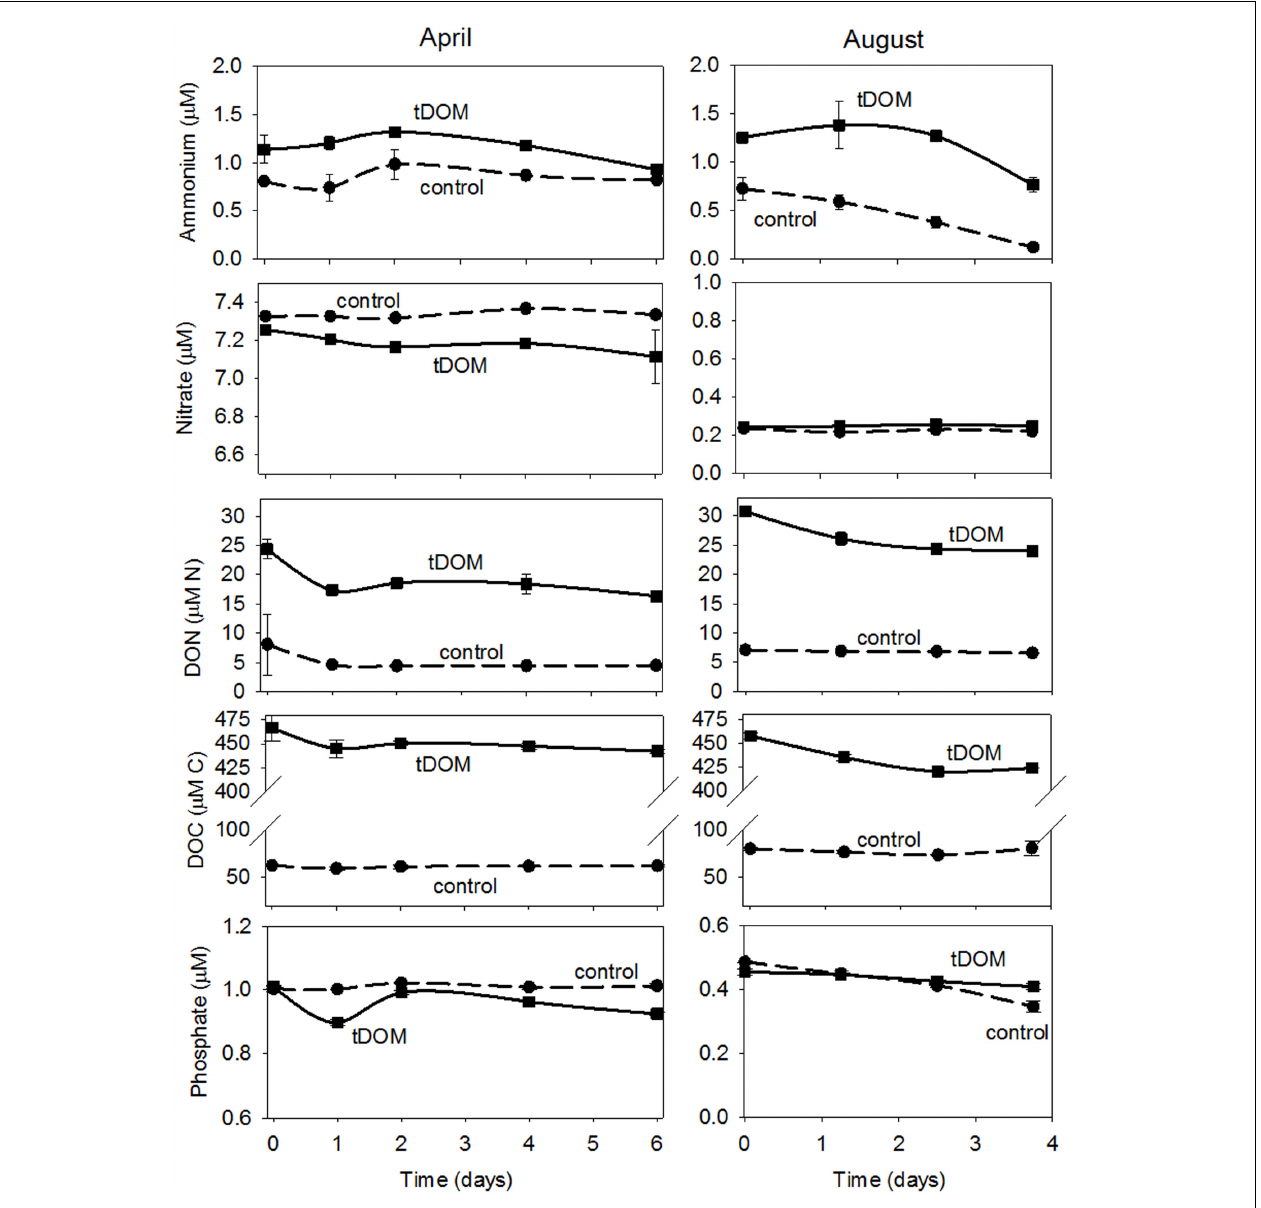
FIGURE 5 | Bioassay nutrient concentrations. Time series nutrient concentration data for April and August bioassays where near coastal Arctic water was amended with terrestrially derived dissolved organic matter (tDOM). Data points are the mean ( n = 2) ± half the range of duplicate samples. The tDOM treatment is depicted by the solid line and the Control treatment which contains no additional DOM, is depicted by the dashed